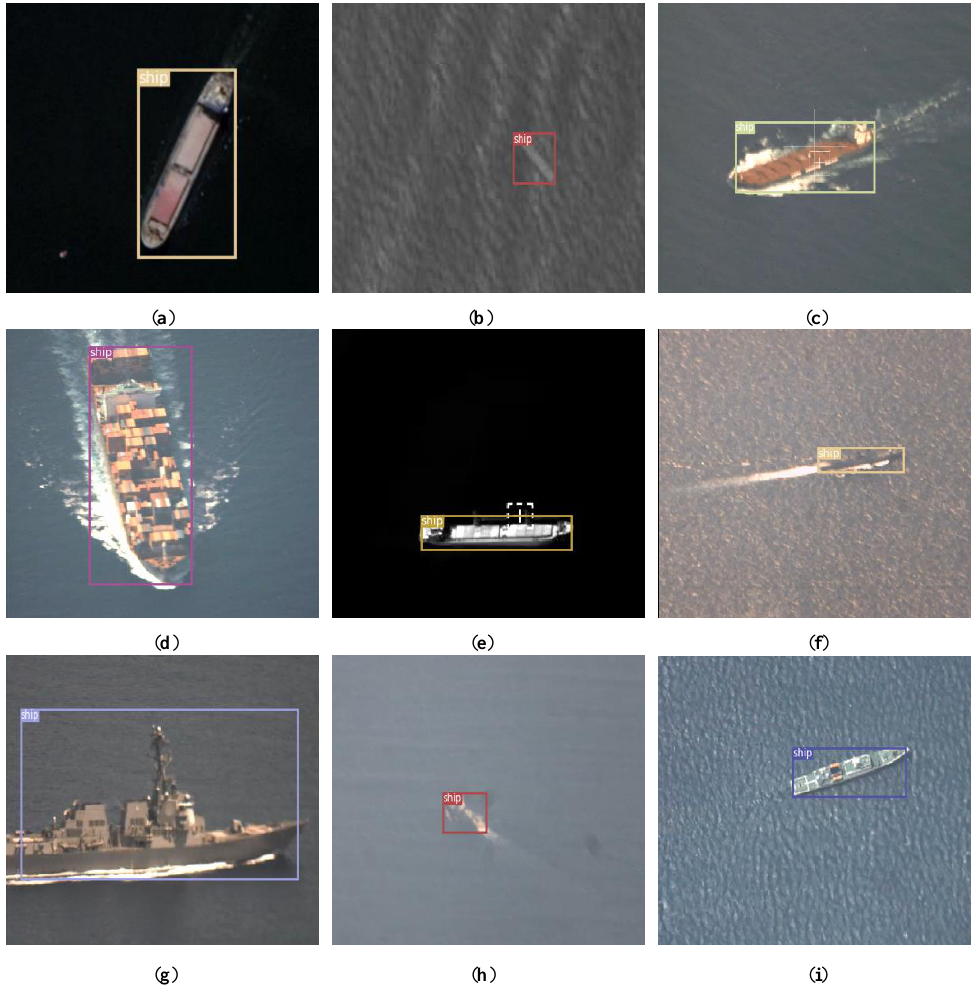
Figure 13. Ship detection results of CFF-SDN model on DSDR dataset. ( a – d ) Ship detection results of visible light images. ( e , f ) Ship detection results of infrared images. ( g – i ) Detection results of ships of di ff erent shapes on visible light